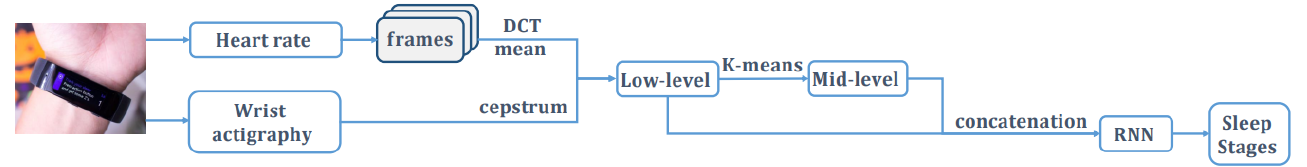
Figure 4. Proposed sleep stage wearable method (Zhang et al., 2018 [33]).